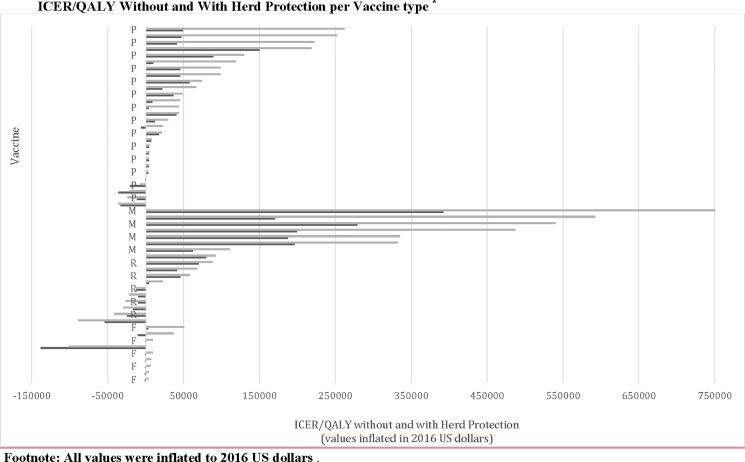
Barplot of ICER per-QALYs without vs. with herd-protection across all four childhood vaccines.X-axis: ICERs per-QALY with herd protection (values inflated to 2016 US dollars, [29]); Grey bars: ICERs per-QALY without Herd Protection; Black bars: ICERs per-QALY with herd-protection. Abbreviations: P = pneumococcal vaccines, M = meningococcal vaccines, R = rotavirus vaccines, F = influenza vaccines.